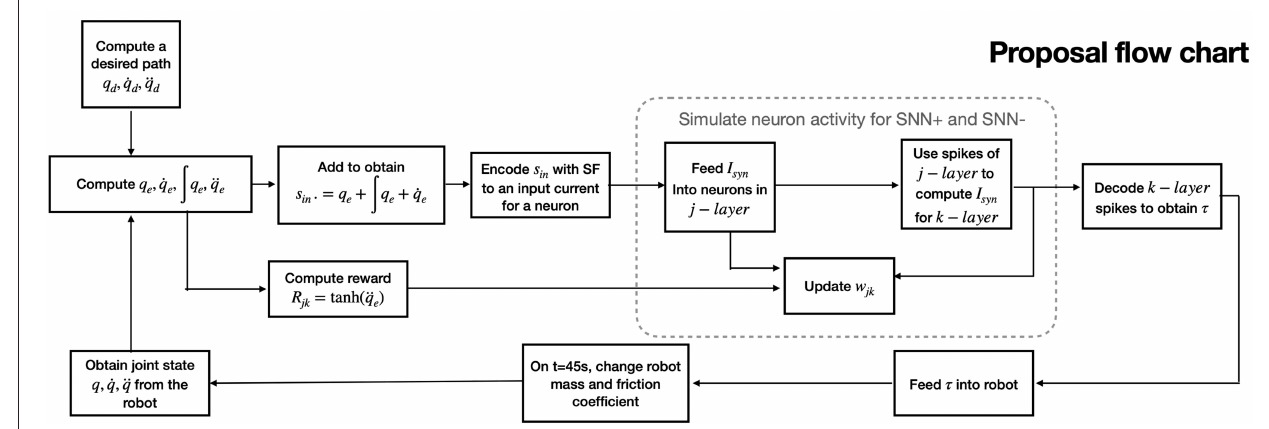
FIGURE 4 | SNN-PID control proposal flow chart showing steps for implementation.